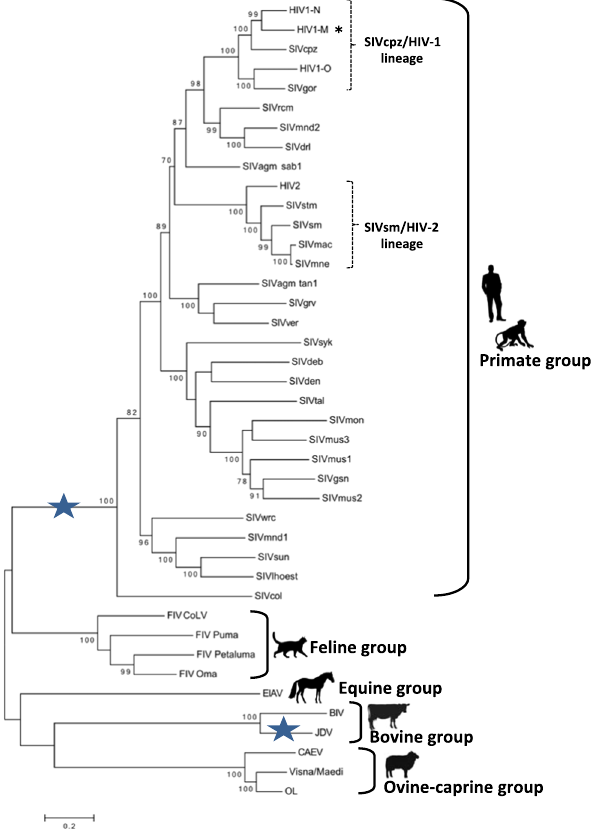
Figure 3. Phylogenetic tree of lentiviruses based on the pol gene. Blue stars correspond to the presence of PQSs in the corresponding group of lentiviruses. The symbol * indicates our reference virus HIV-1 group M. Human and animal silhouettes were obtained at http://www.freepik.com and http://www.flaticon.com/ (http://www. freepik.com/free-vector/business-team-outlines-pack_831669.htm#term = human; http://www.flaticon.com/ free-icon/monkey_47138; http://www.freepik.com/free-vector/cat-silhouettes-set_718091.htm#term = cat; http://www.flaticon.com/free-icon/horse-standing-black-shape_35907; http://www.freepik.com/free- vector/cows-and-bull-silhouettes_788343.htm; http://www.freepik.com/free-vector/pack-of-farm-animal- silhouettes_1058750.htm#term = sheep&page = 1&position =